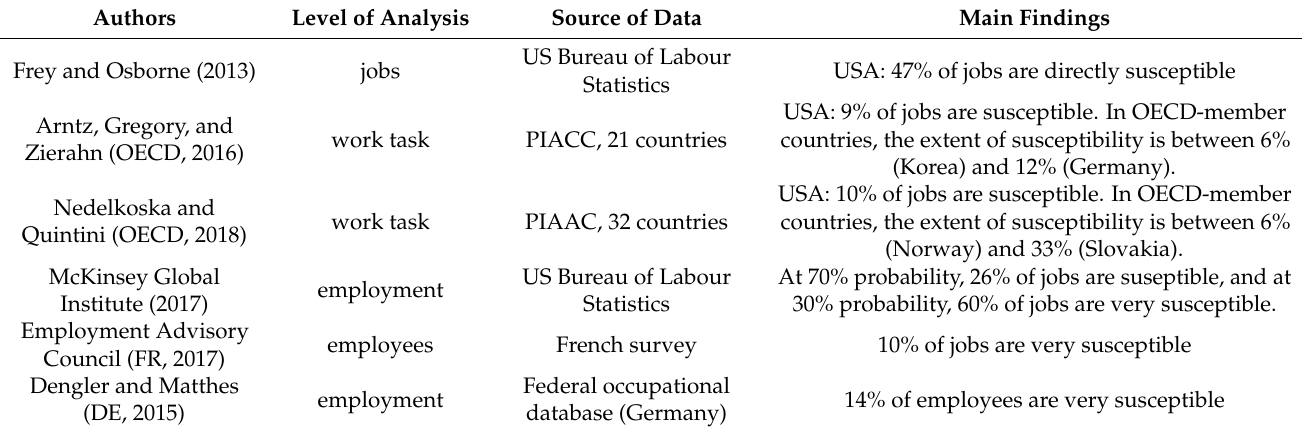
Table 2. Findings of the most important studies on